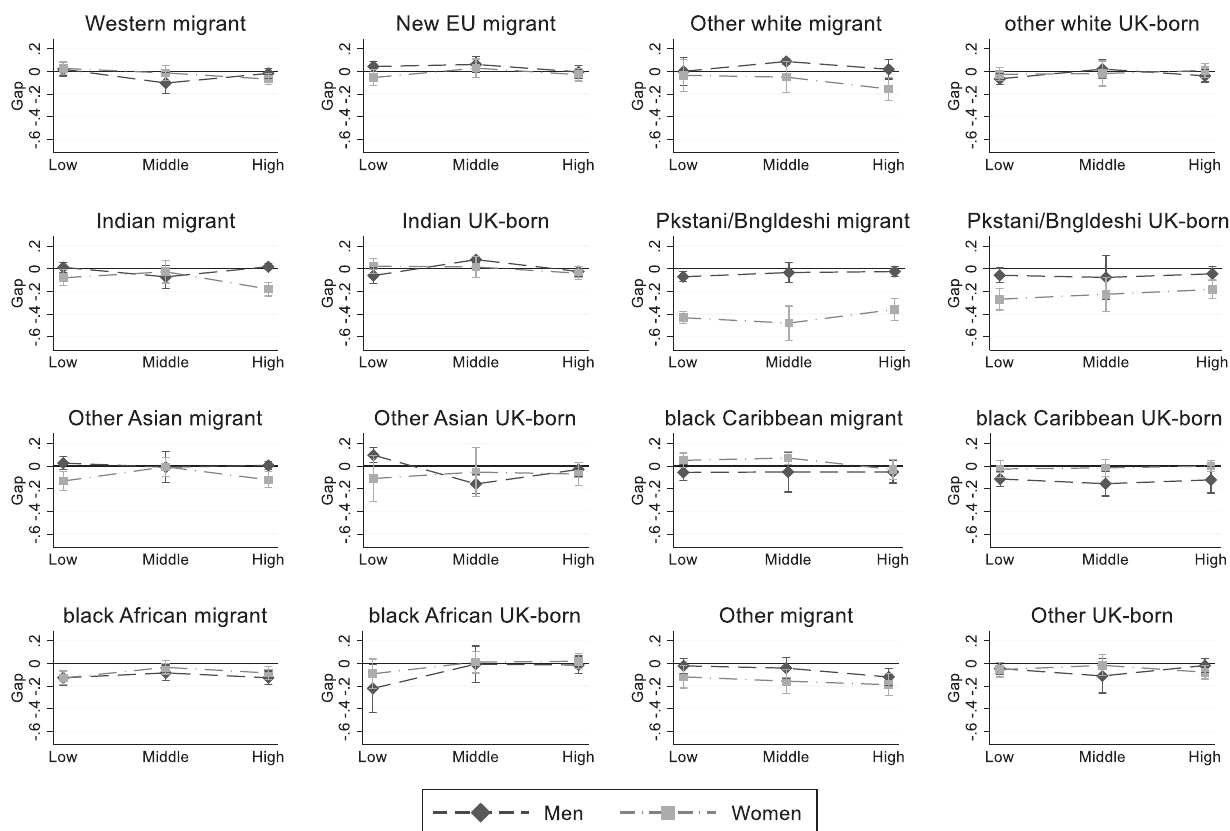
Figure 1. Estimated difference (95% Confidence interval) from white British majority in probability of